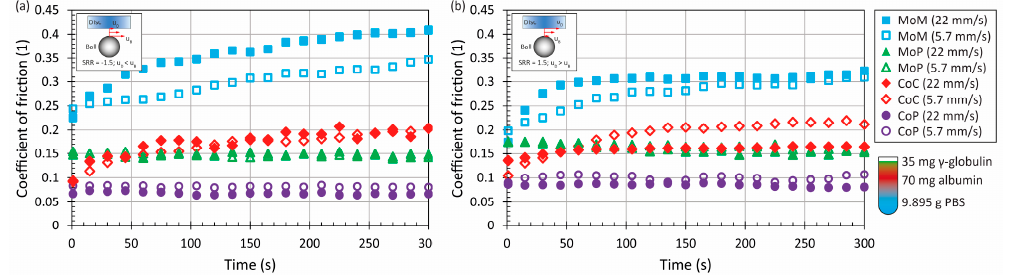
Figure 3. Development of CoF as a function of time for four material combinations at lower and higher mean speed under negative ( a ) and positive ( b ) sliding conditions. Contact is lubricated by model fluid Alb70+Glob35.